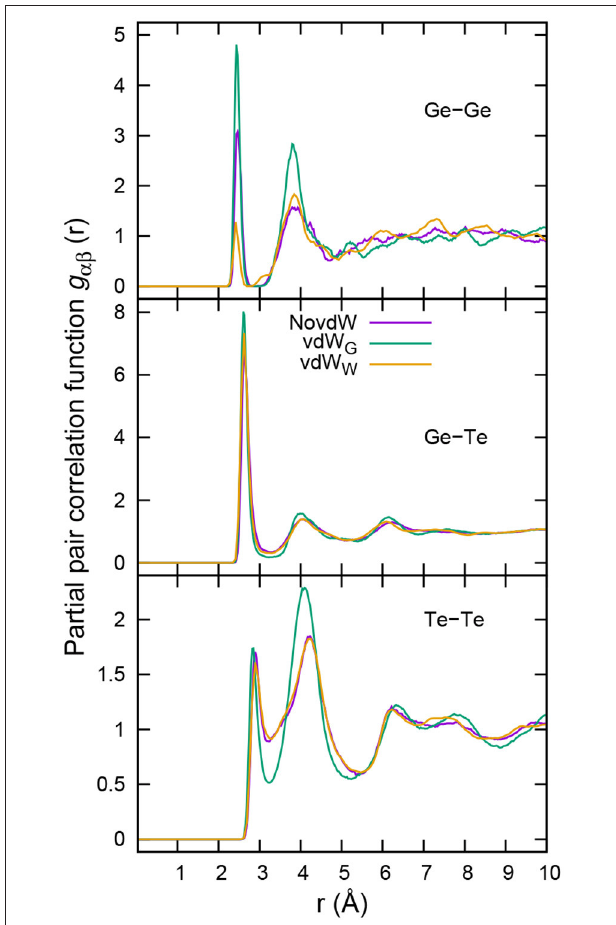
FIGURE 2 | Partial pair correlation functions of g -GeTe 4 . Results with no inclusion of vdW interactions (purple line) and with inclusion of vdW interactions following the Grimme scheme (vdW G , green line) (as reported by Bouzid et al., 2015b) are compared to those including van der Waals interaction in the vdW W formalism (orange